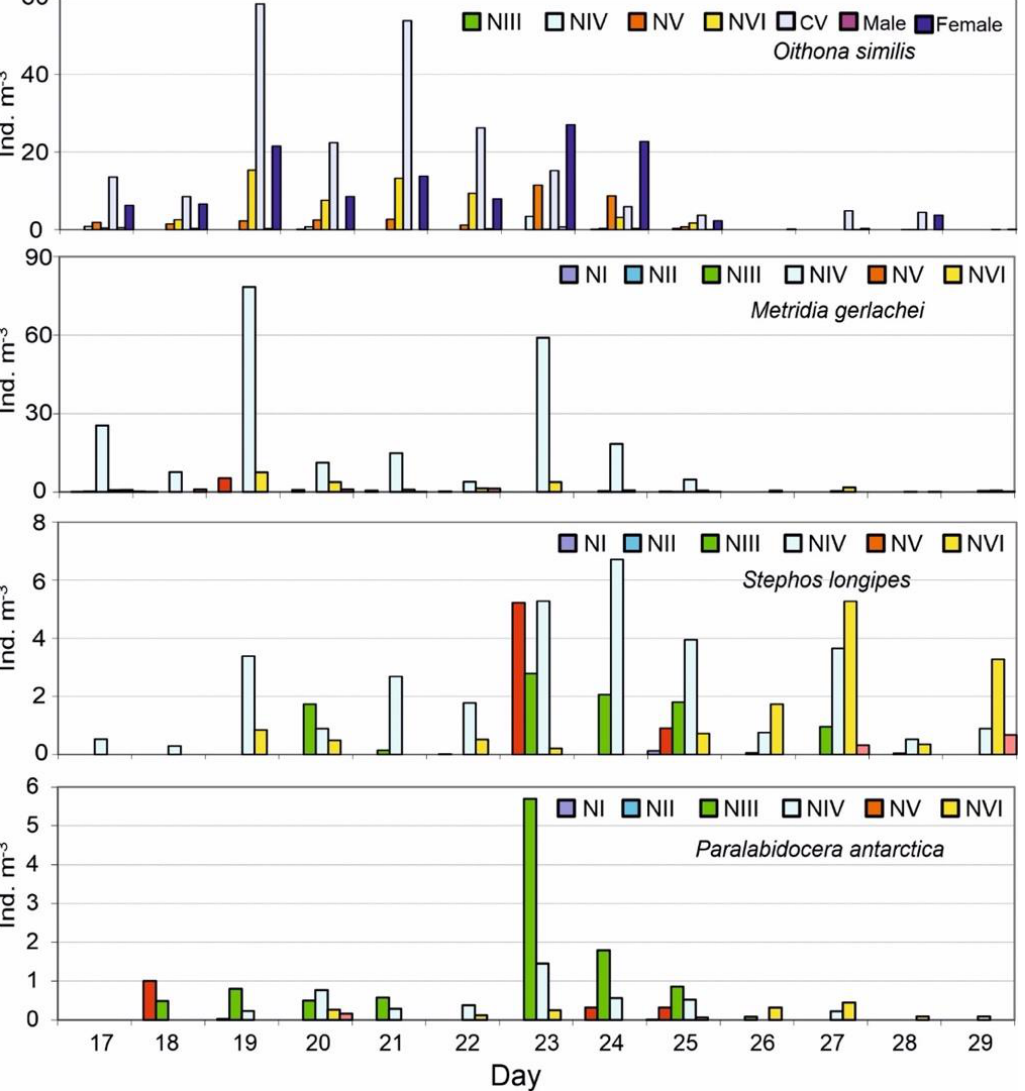
Figure 8. PIPEX 97 cruise, Terra Nova Bay, Antarctica 1997. Average abundance (ind m −3 ) of the four most representative adult and development stages copepod species throughout the sampling period. Note that naupliar stages NI and NII were not found for the species O. similis , which presented conversely copepodites (only CV) and male/female adults.